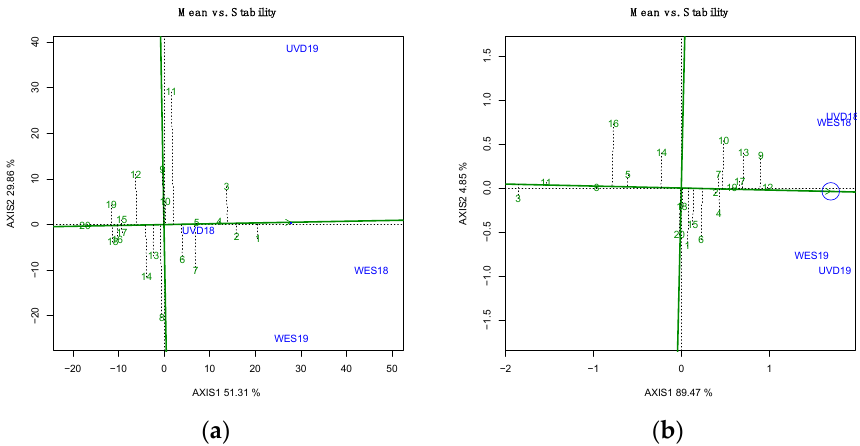
Figure 1. Mean vs. stability biplot ( a ) for TY and ( b ) for total soluble solids (TSS) evaluated in Weslaco and Uvalde in 2018 and 2019. Locations were showed with three letters abbreviation and years were shown with 2-digits (in blue color; UVD = Uvalde TX; WES = Weslaco TX; 18 = summer 2018; 19 = summer 2019). The numbers (green colored) on the biplots correspond to the corresponding numbers for genotypes found in Table